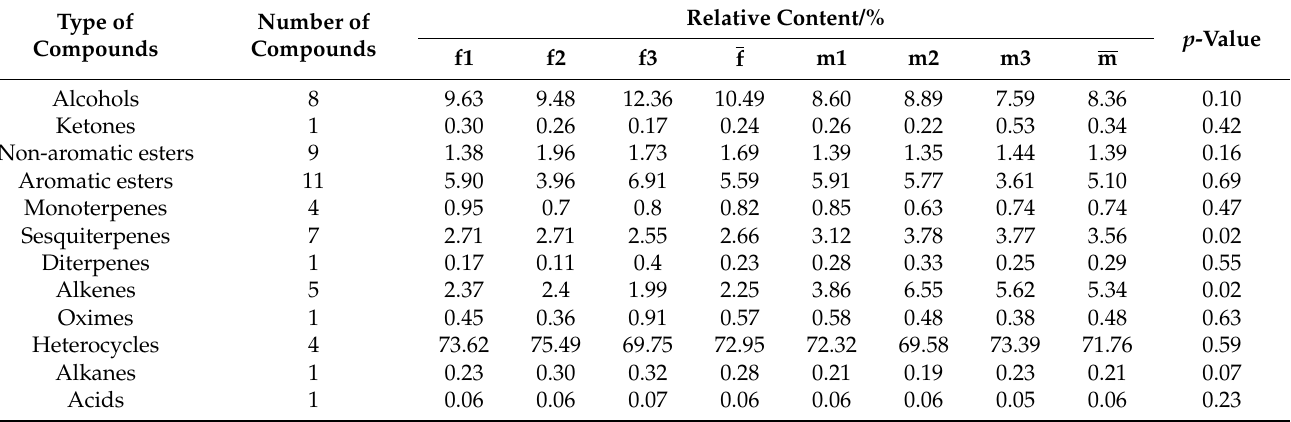
Table 2. The relative content of different types of volatile compounds in female and male T. anguina buds.